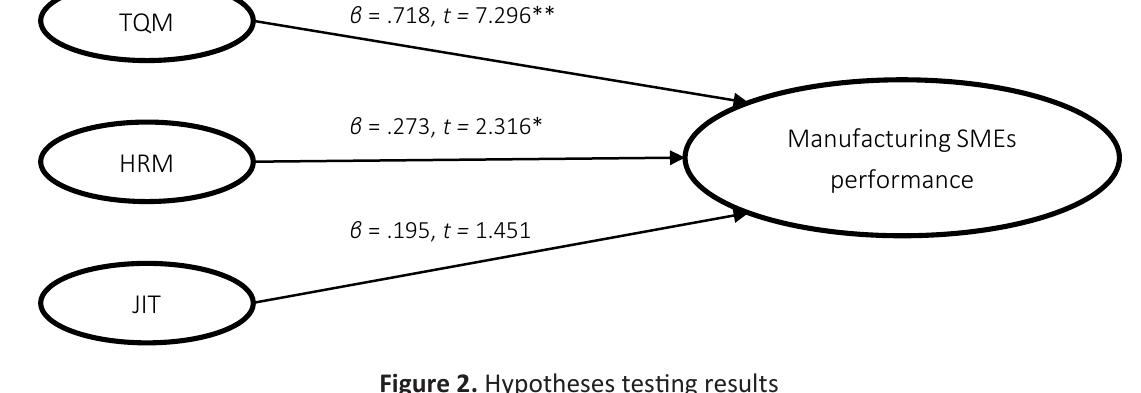
Figure 2. Hypotheses testing results